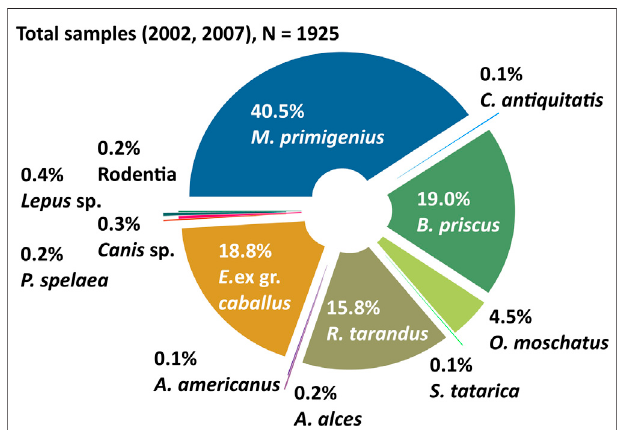
FIGURE 4 | Composition of the mammal bone collections from Oyogos Yar showing the total collection from 2002 to 2007 (N = 1925). The percentages are calculated from the total number of identi fi ed samples ( Table 1 ).